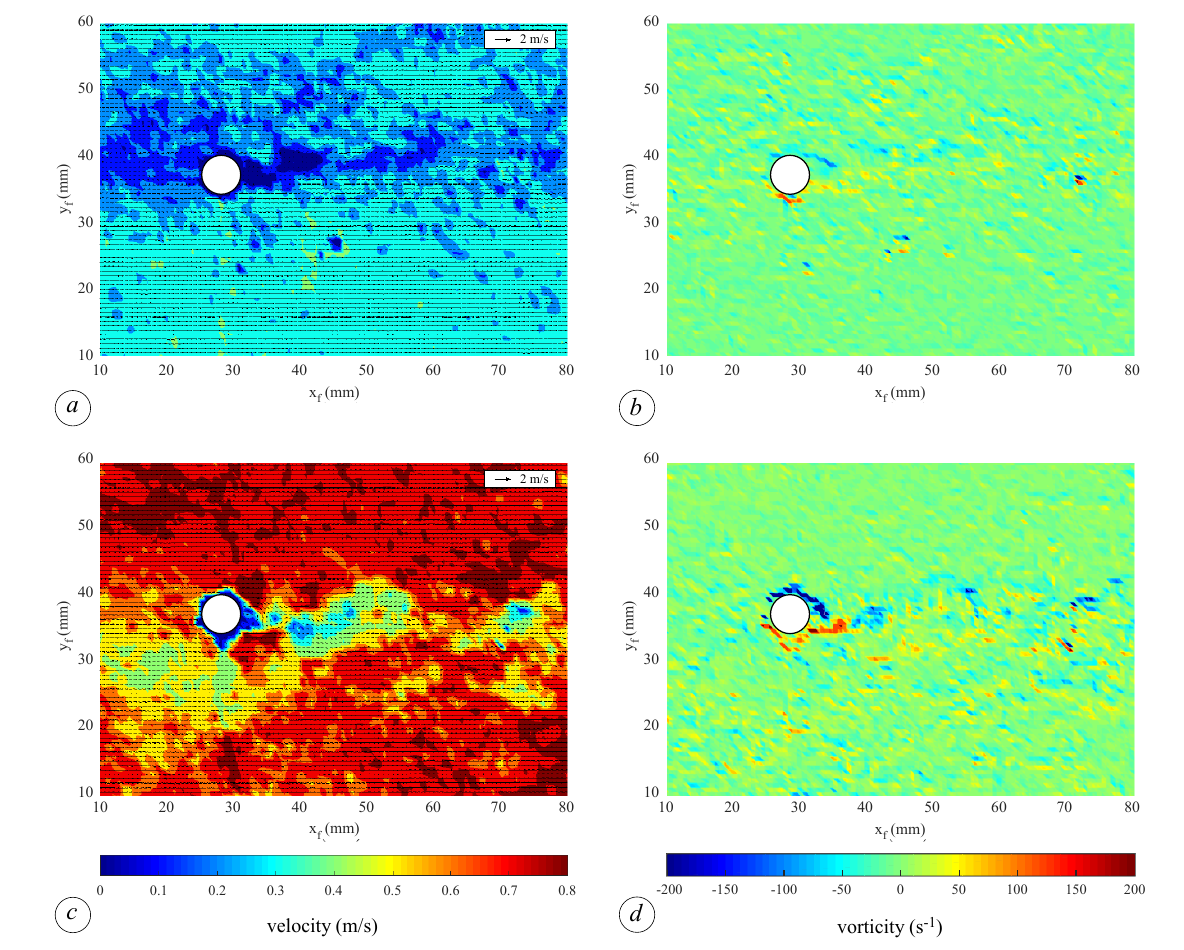
Figure 9. Example of PIV measurements at x = 9.00 m and z = 2 cm: velocity field during base flow condition ( a ) and at the wave peak ( c ); vorticity during base flow condition ( b ) and at the wave peak ( d ). The local coordinate system ( x f , y f ) refers to the frame. The flow is from left to